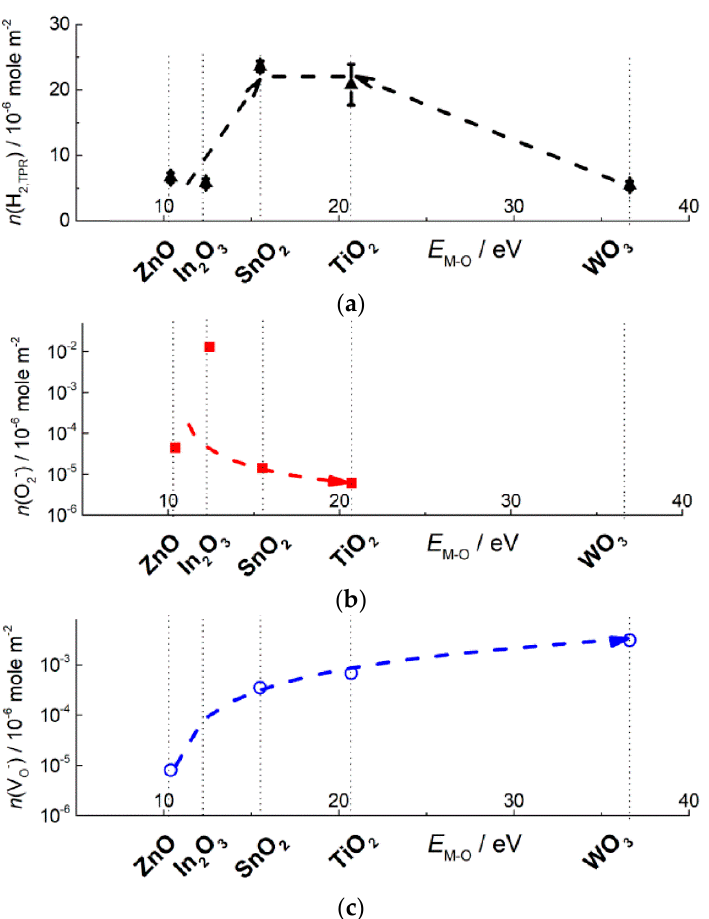
Figure 14. Concentration of active sites at the surface of nanocrystalline n -type MOS in relation to metal-oxygen bond energy: oxidizing sites estimated from H 2 consumption in TPR at temperature below 300 °C ( a ), ionosorbed oxygen O 2 − determined by EPR ( b ), and donor sites (V O − ) determined by EPR ( c ). The values are taken from Table 2.